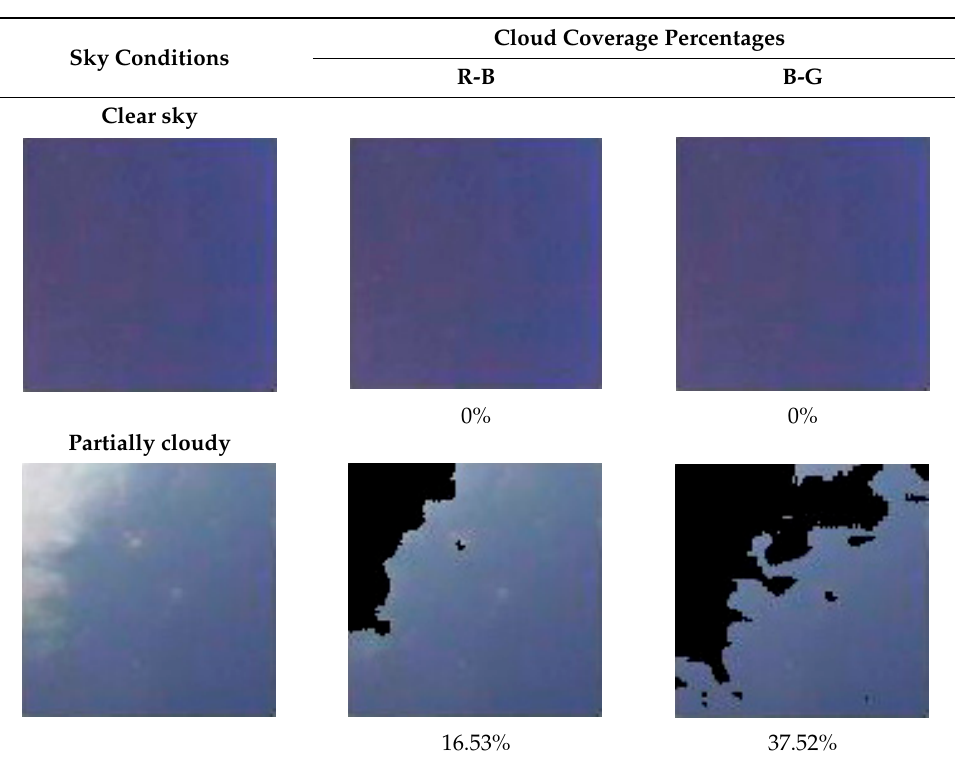
Table 3. Thin cloud detection and coverage percentage for B-G and R-B Color Difference .